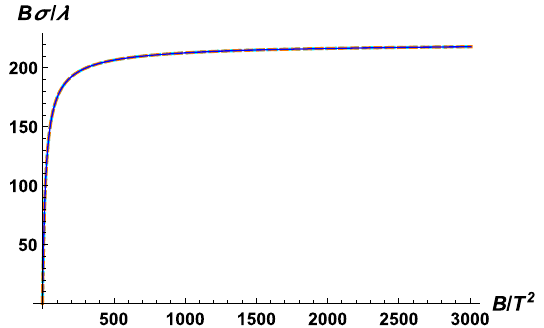
(with anomaly coef- h , h